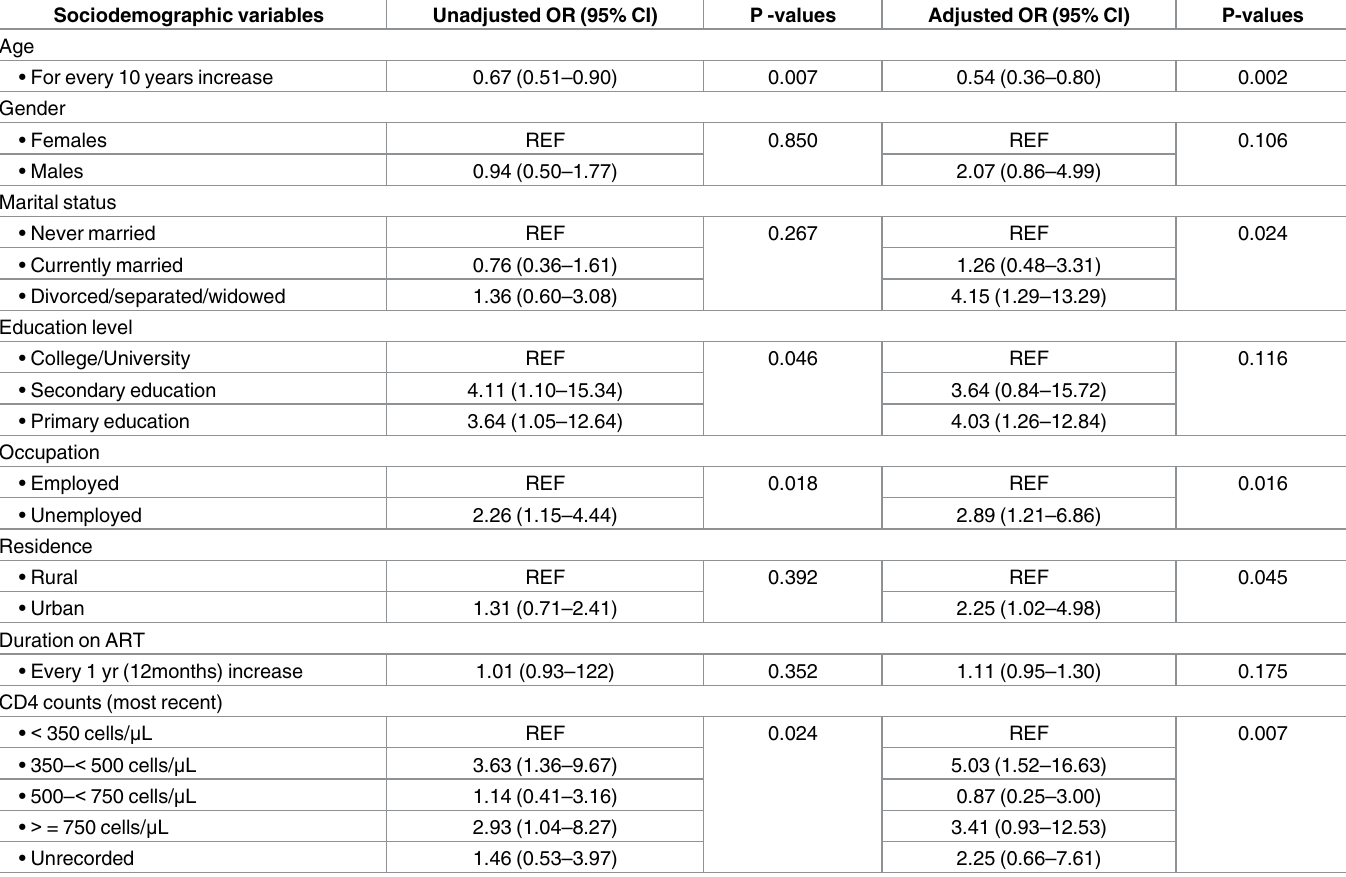
Table 5. Unadjusted and adjusted odds ratios (OR) for predictors of non-adherence to antiretroviral therapy among HIV-infected north Tanzanians using 80% adherence threshold. Sociodemographic